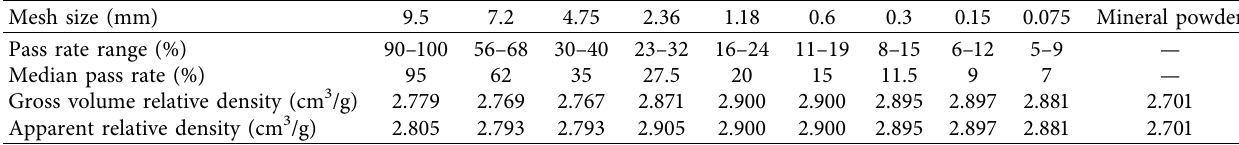
Table 2: Gradation and density values for different grain